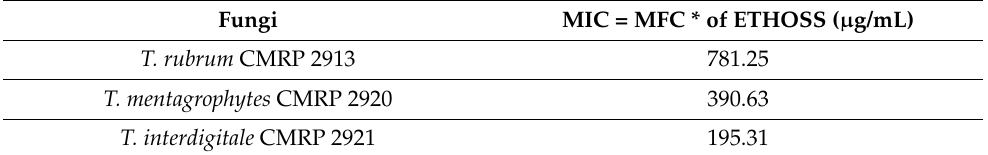
Table 1. Evaluation of Minimum Inhibitory Concentration (MIC) and Minimum Fungicidal Con- centration (MFC) of Sapindus saponaria L. hydroalcoholic extract (ETHOSS) against Trichophyton spp. isolated from patients with